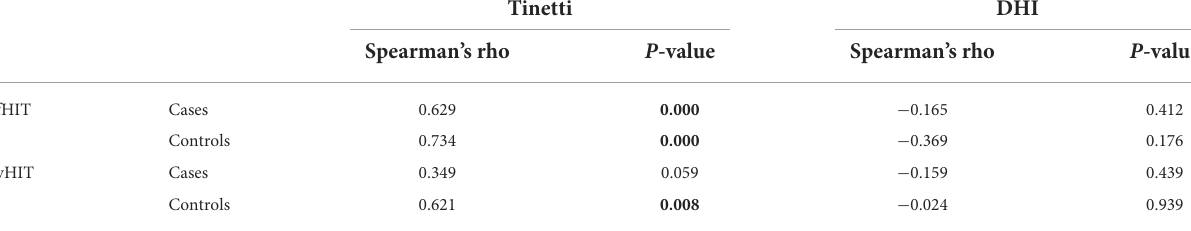
TABLE 3 Non-parametric correlations between Tinetti/DHI scores and fHIT/vHIT in cases and controls.